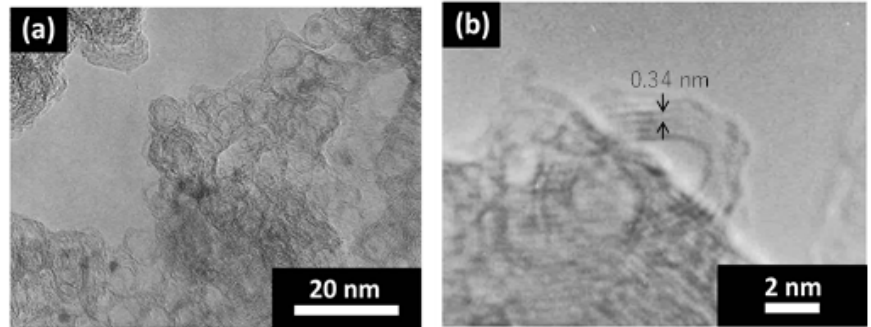
Figure 10. TEM image of the nanoparticle products formed using pulsed discharge plasma ( a ) and their magnification ( b ) [40].